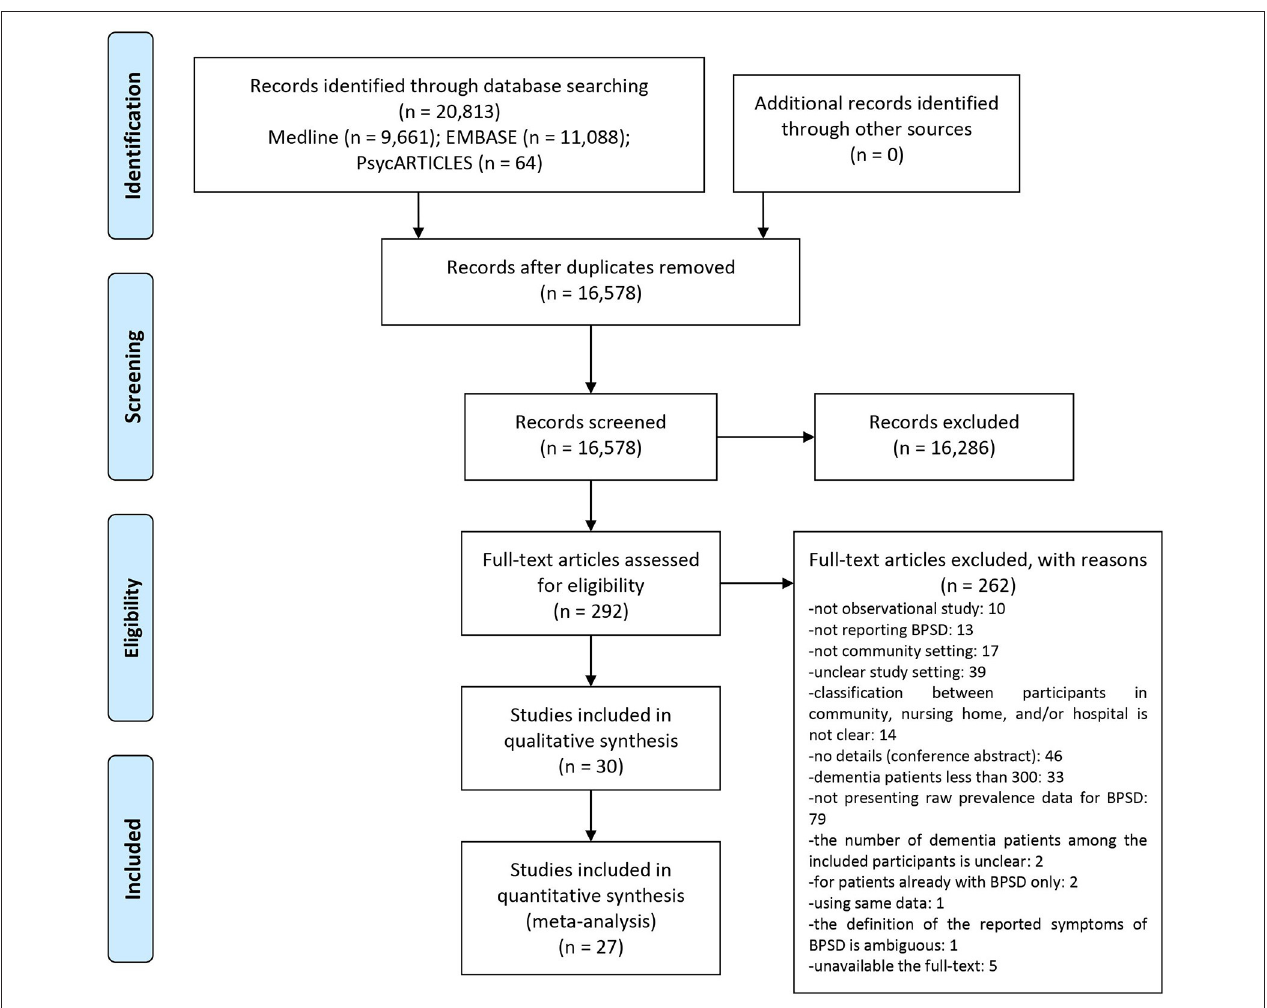
FIGURE 1 | PRISMA flow chart of this